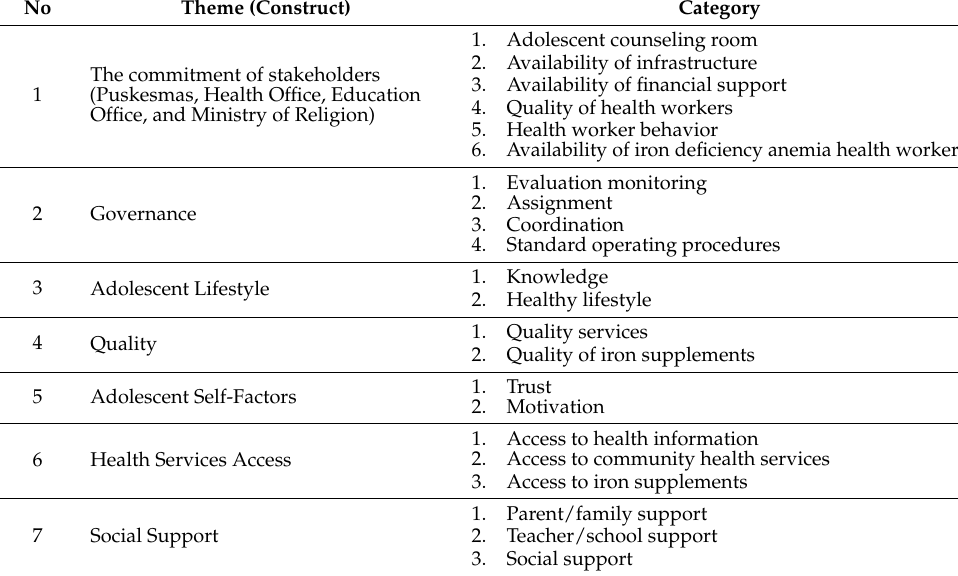
Table 2. Analytical